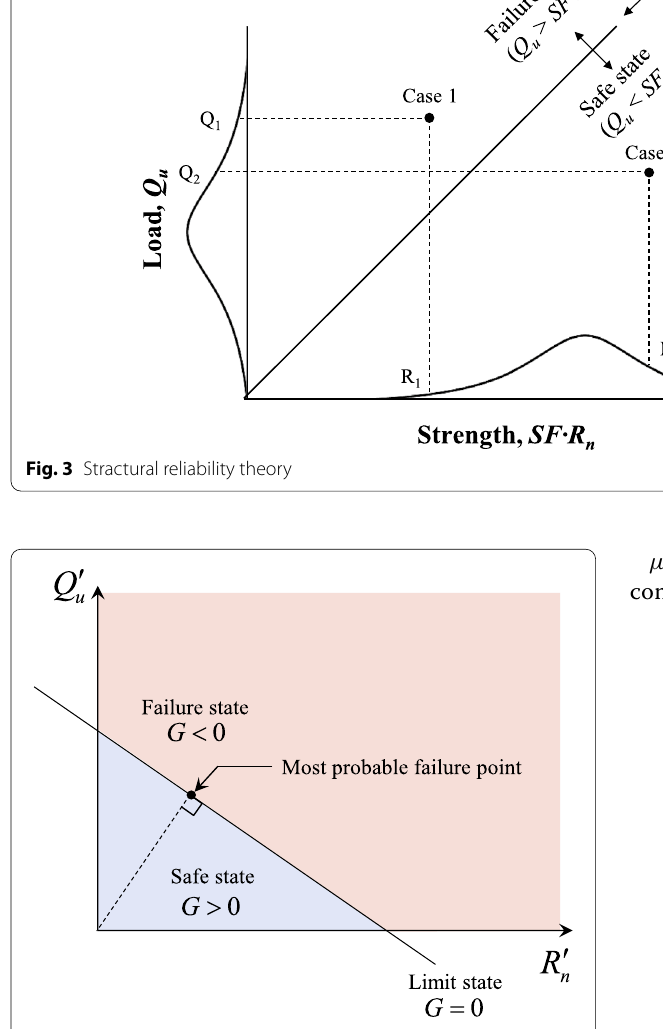
Fig. 4 Most probable failure